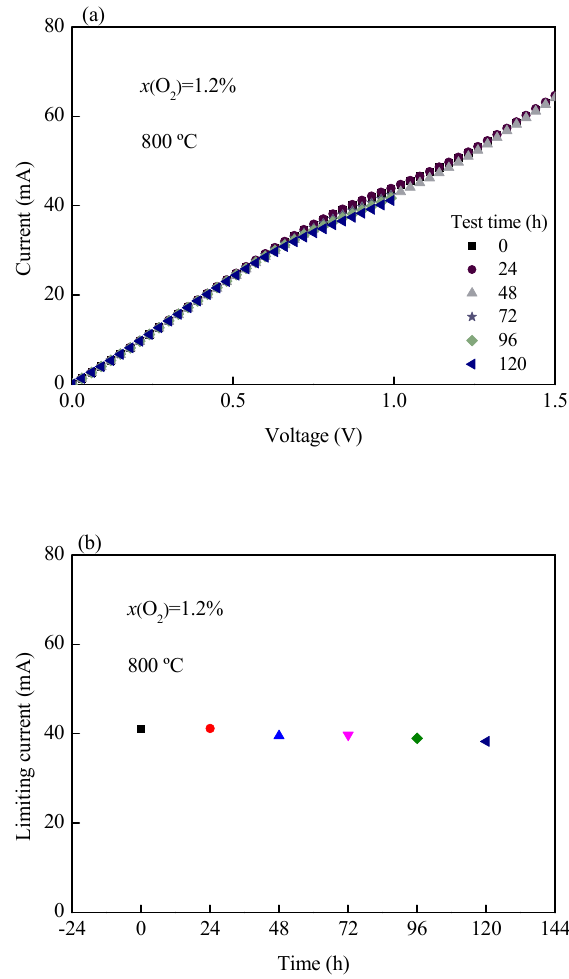
Figure 11. ( a ) I-V curves from 0 to 120 h, ( b ) limiting current from 0 to 120 h.